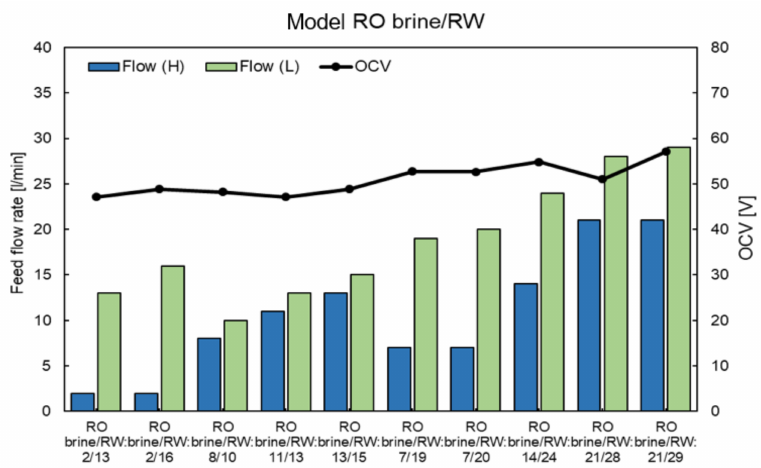
Figure A6. OCVs of RED stack using the model RO brine and RW feed solution at different feed flow rates.